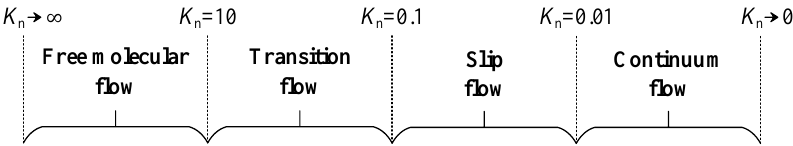
Figure 2. Aerodynamic drag loss relative to the pressure at different air gaps.